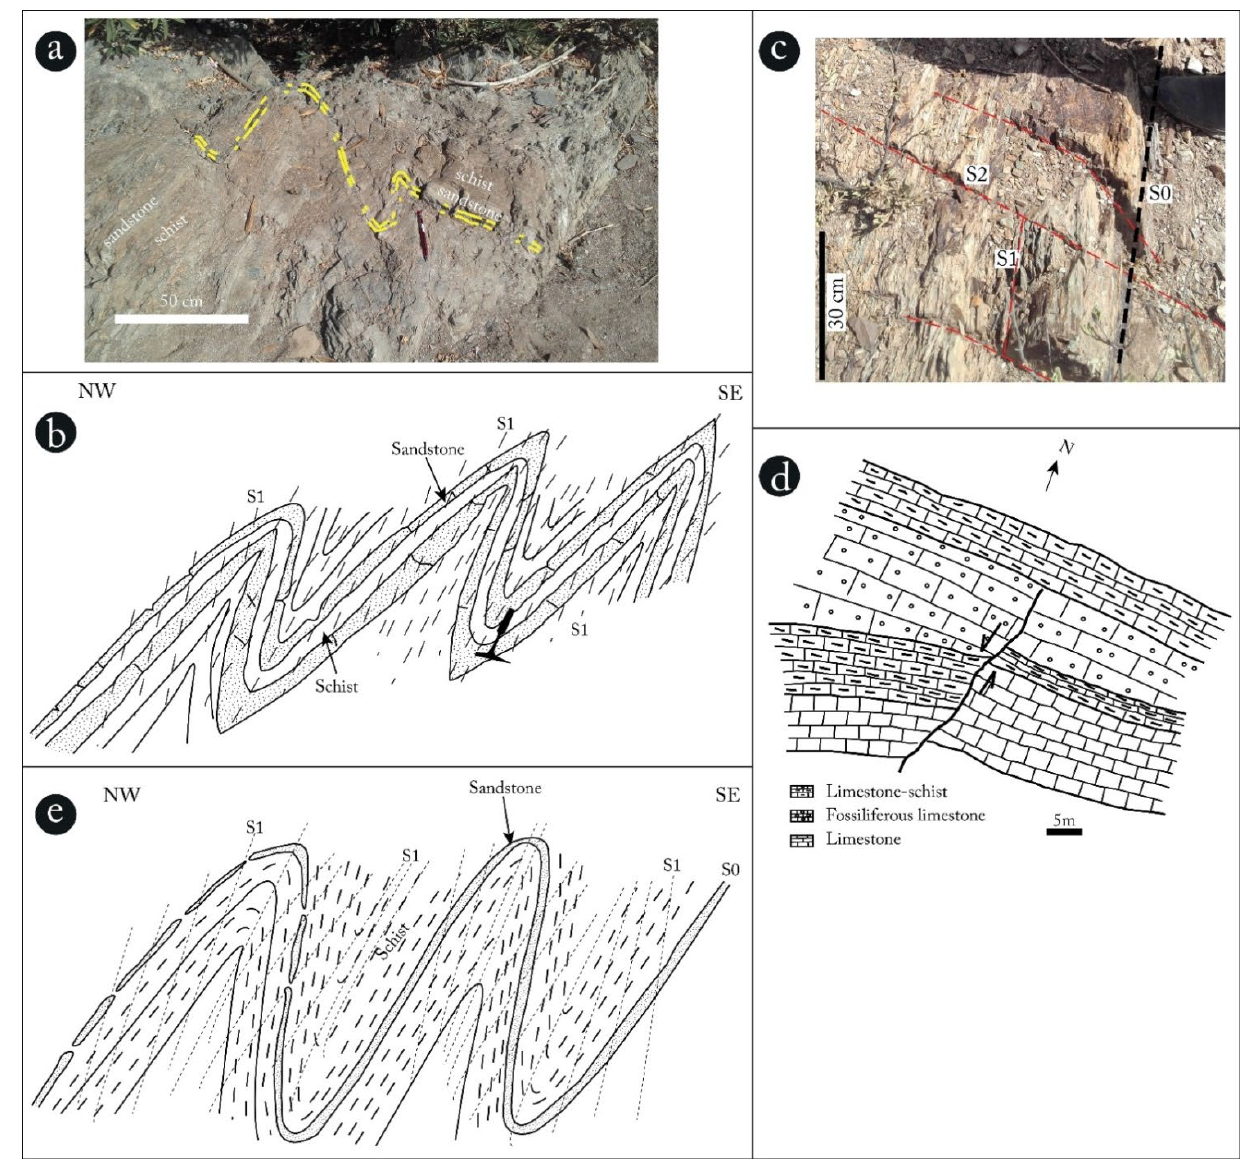
Figure 8. Folding types in the NNE Achemmach: ( a , b ) N-S synschist metric folds with eastern vergence of the flysch series, ( c ) relationship between schistosity and stratification ( d ) syn-sedimentary normal fault in a limestone bench of the Bergamou limestone bar (northern part of the studied area), and ( e ) NE-SW metric folds with SE vergence of the supra-calcareous schisto-sandstone formation.